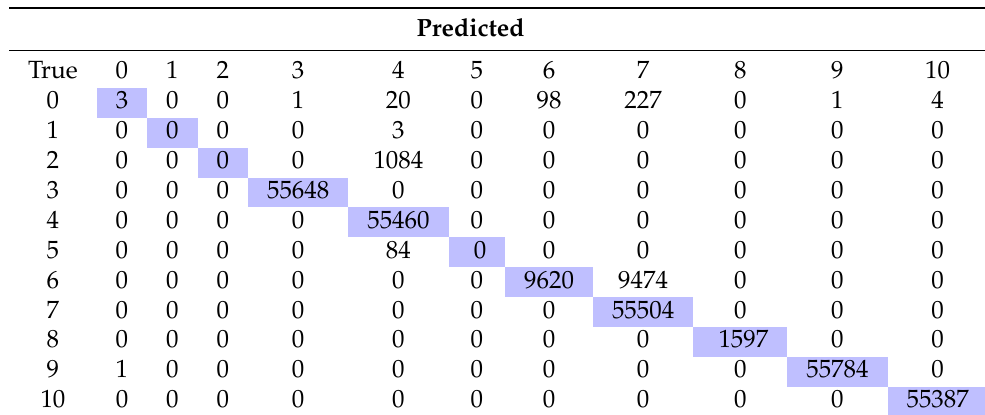
Table 45. DT confusion